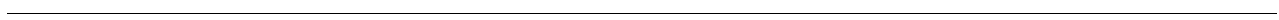
Fig. 9a). To directly